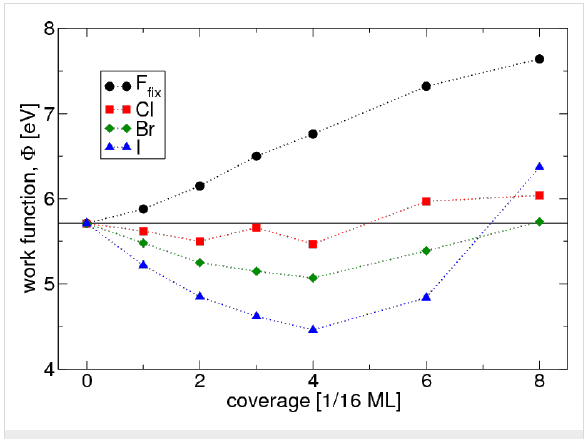
Figure 2: Calculated change of the work function vs coverage for the adsorption of fluorine, chlorine, bromine and iodine on Pt(111). The high value for the 0.5 ML calculation of iodine is due to a double layer structure of the adsorbates, caused by the larger size of iodine atoms.